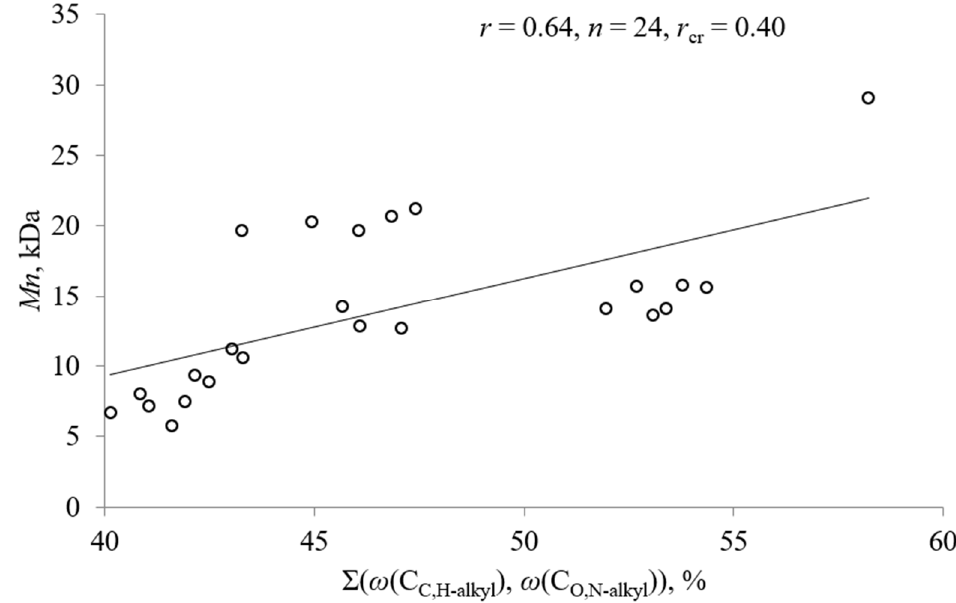
Figure 7. The dependence of the number average molecular weight on the proportion of aliphatic fragments ( 13 С NMR) of HAs from Plot 2-1 and Plot 2-2.